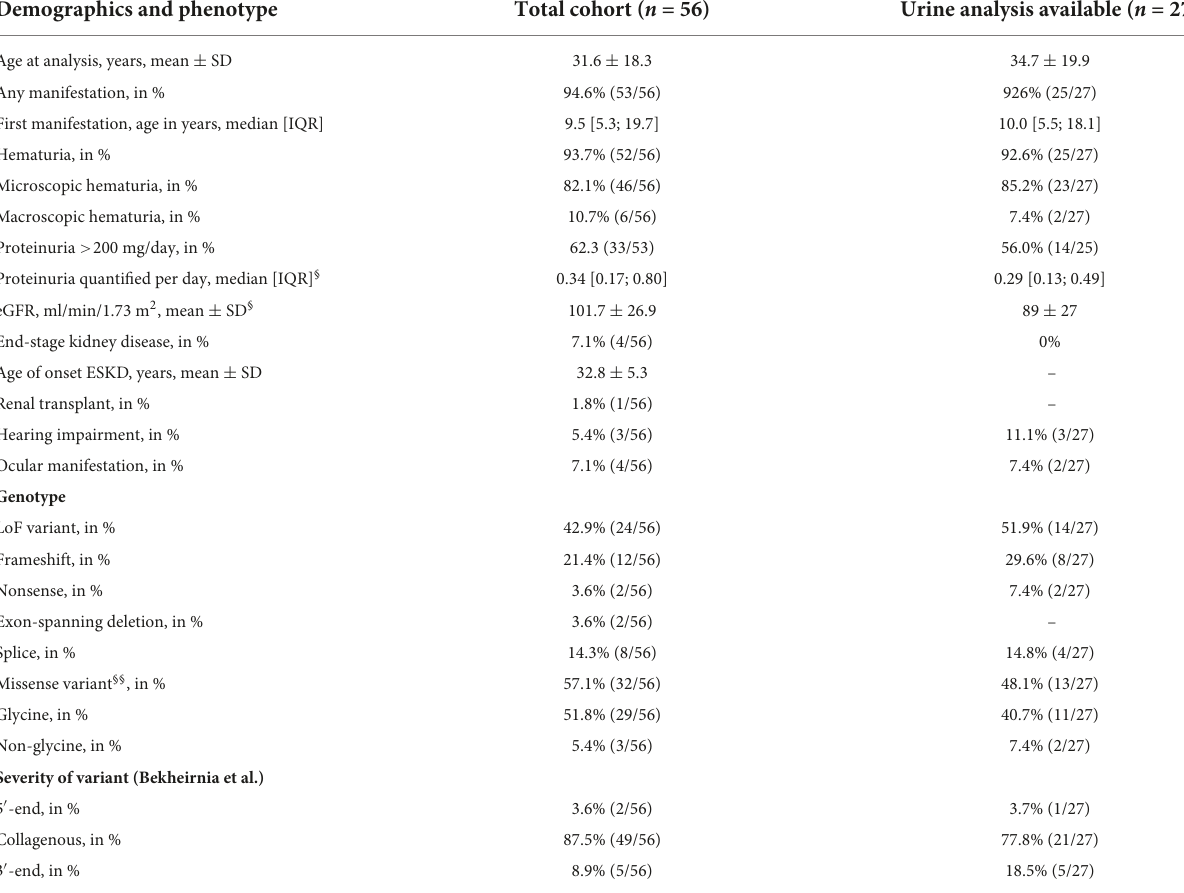
TABLE 3 Phenotype and genotype of individuals for total and urine-analysis containing